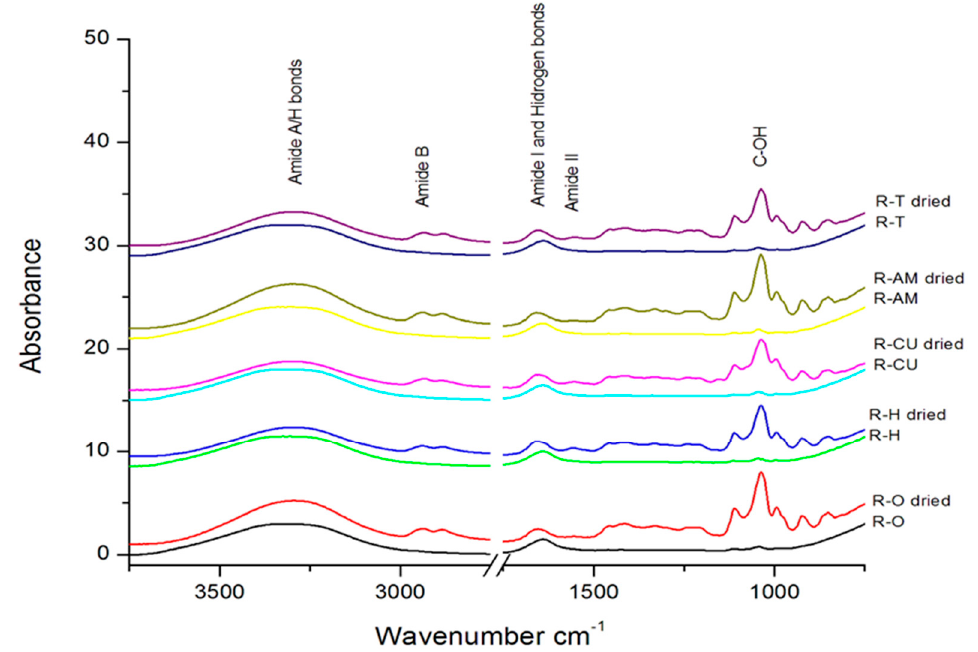
Figure 3. IR spectra for the experimental PS gels with essential oils and for dried gels. Table 2. The main vibration bands from gels and dried gels.